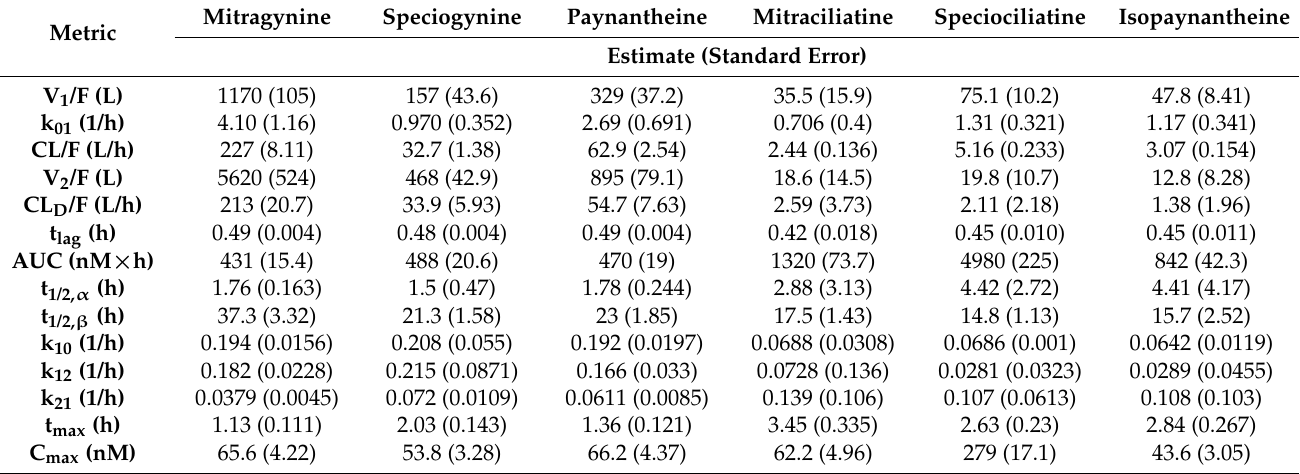
phase; k 10 , elimination rate constant for loss from the central compartment; k 12 , intercompartmental distribution rate constant from the central to the peripheral compartment; k 21 , intercompartmental distribution rate constant from the peripheral to the central compartment; t max , time to reach C max ; C max , maximum plasma concentration. Regarding NCA of the individual concentration-time profiles, all extrapolated AUCs for alkaloids beyond the respective C last were less than 20%, ensuring robust estimates of terminal t 1/2 , CL/F, V z /F, and AUC inf . These outcomes, along with C max and t max , were distinct between the two types of alkaloids. That is, the 3 S alkaloids exhibited a longer terminal t 1/2 , higher CL/F and V z /F, lower dose-normalized AUC inf and C max , and shorter t max than the 3 R alkaloids (Table 1). The 7-hydroxymitragynine-to-mitragynine C max and AUC inf ratios ranged from ~0.24 – 0.27.